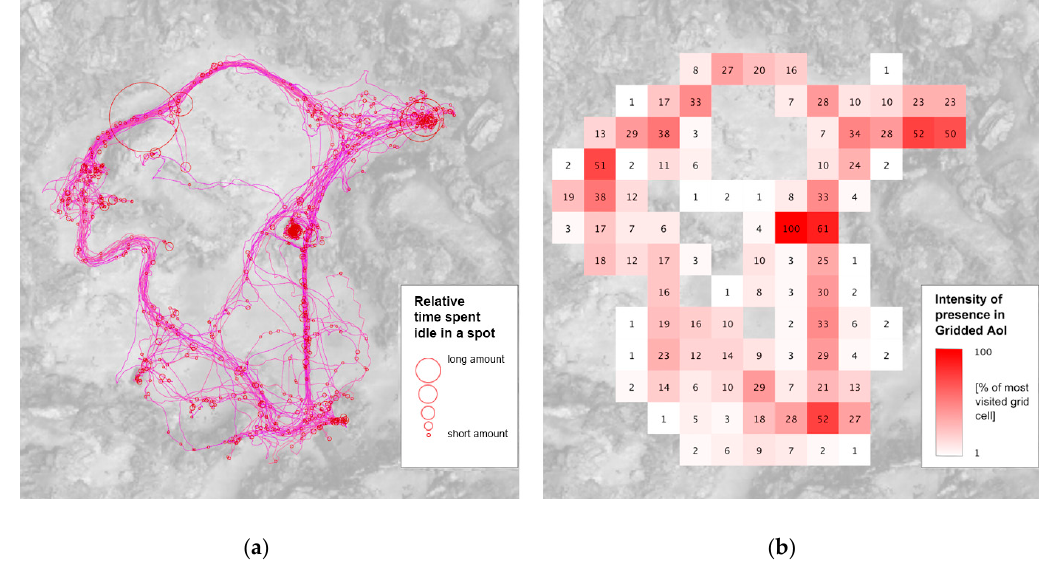
Figure 6. Virtual trajectories (paths) of all individual participants combined ( a ), Gridded AoI average for all paths ( b ).